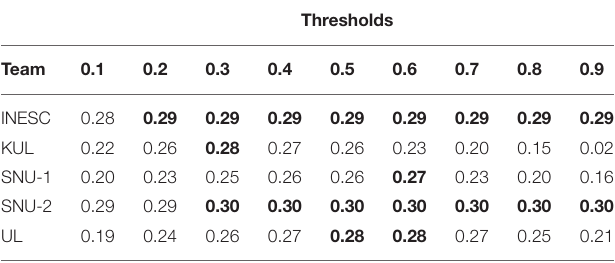
TABLE A1 | Dice score dependency of threshold for softmax maps.